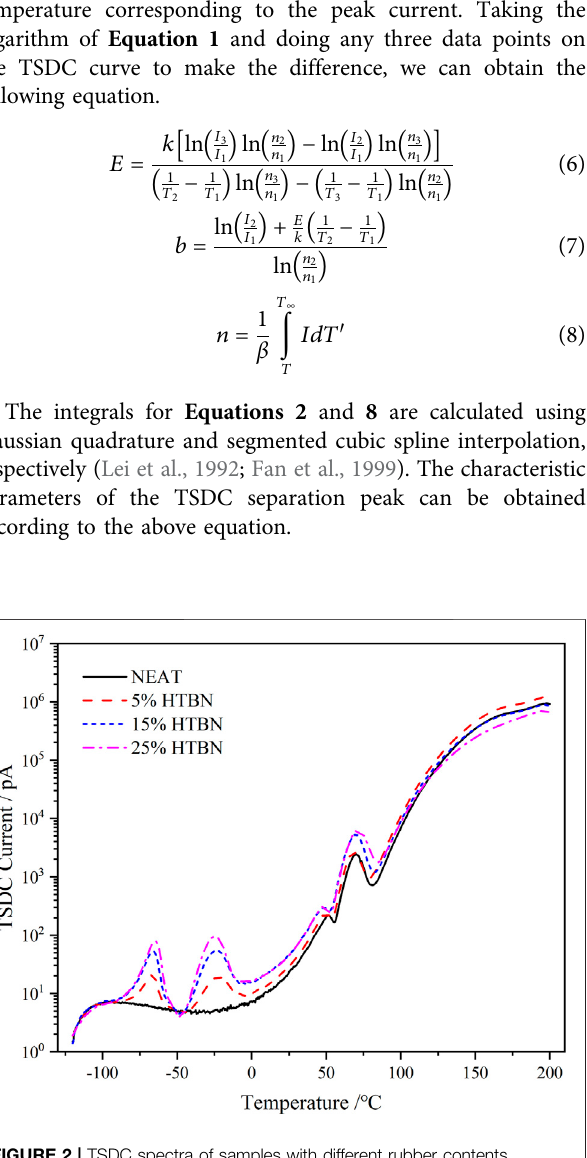
FIGURE 2 | TSDC spectra of samples with different rubber